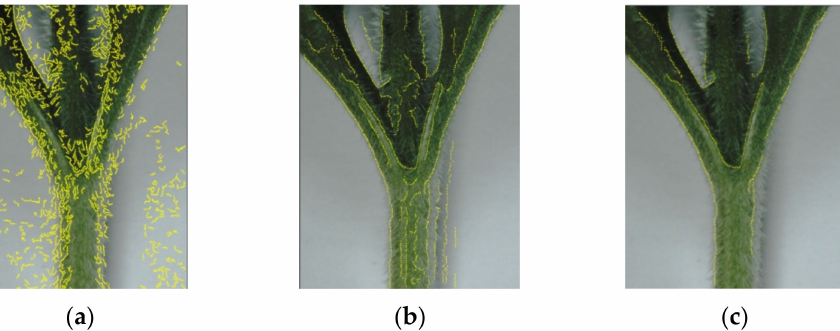
Figure 6. Image feature extraction: ( a ) initial state, ( b ) mask processing, and ( c ) threshold